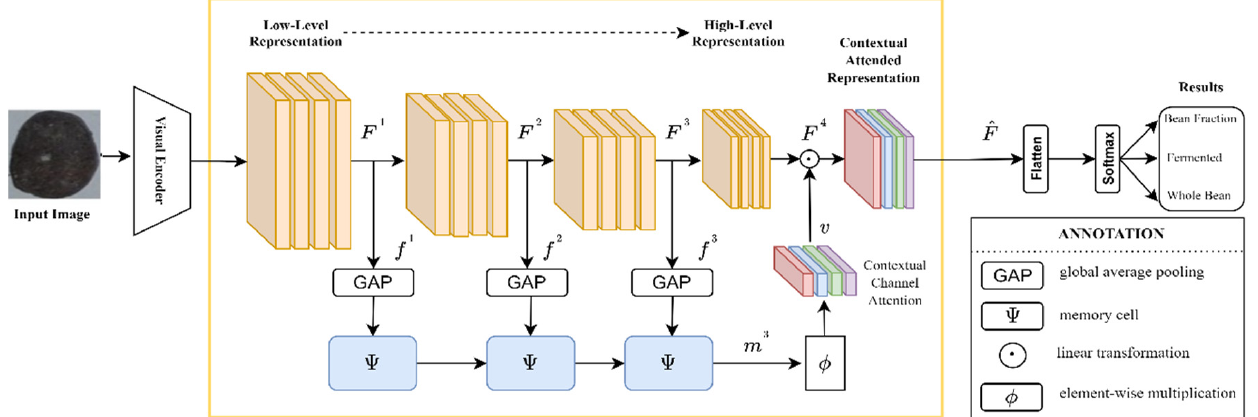
Figure 1. Progressive Contextual Excitation Network (PCENet).